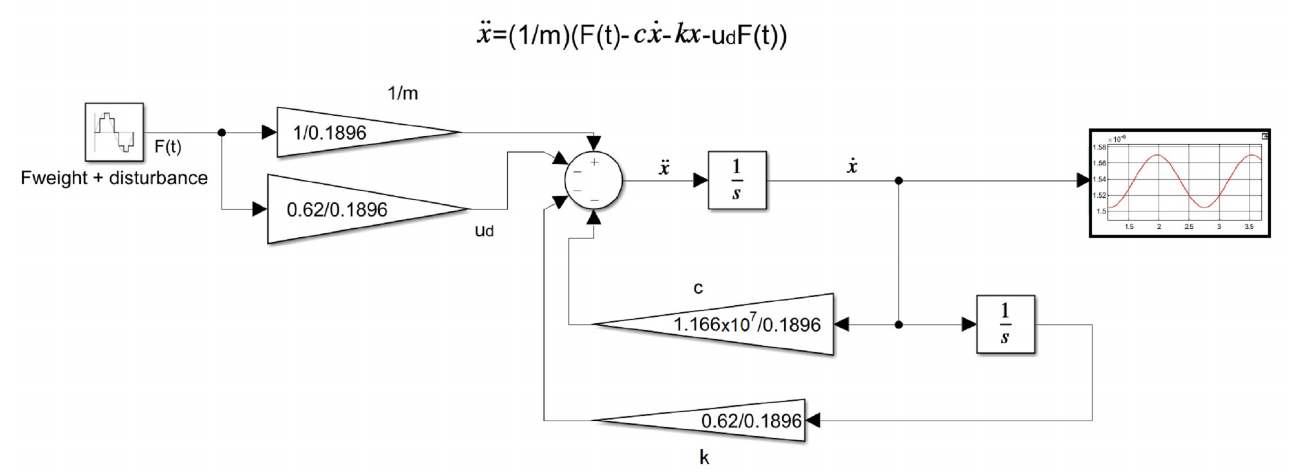
Figure 4. Block diagram for the M.S.D.F. equivalent system in firm mud soil.